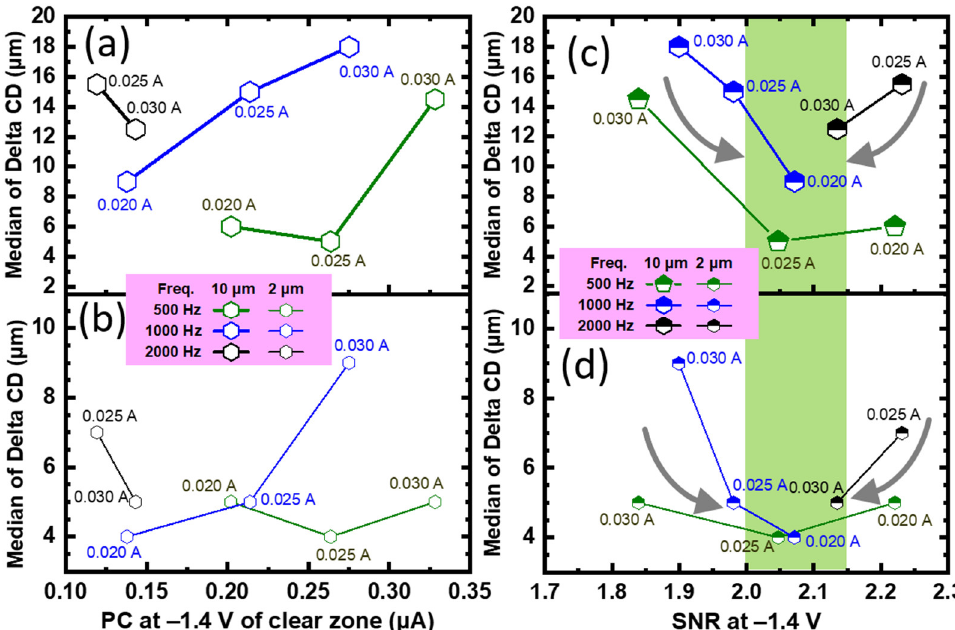
Figure 6. The photocurrent measured at −1.4 V in clear ozone versus the median value of delta CD for step spacings of ( a ) 10 and ( b ) 2 μm. The SNR at −1.4 V in the clear ozone versus the median value of delta CD for step spacings of ( c ) 10 and ( d ) 2 μm. A clear optimized operating region for a small delta CD can be found for SNRs from 2.0 to 2.15.